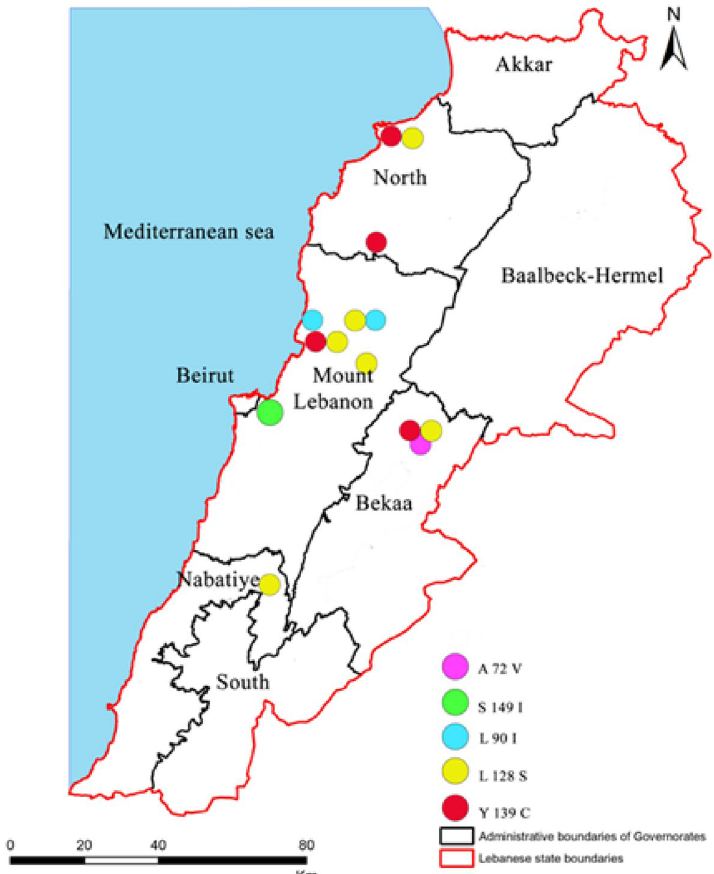
Figure 2. Distribution of Vkorc1 mutations in the genus Rattus and Mus in the governorates of